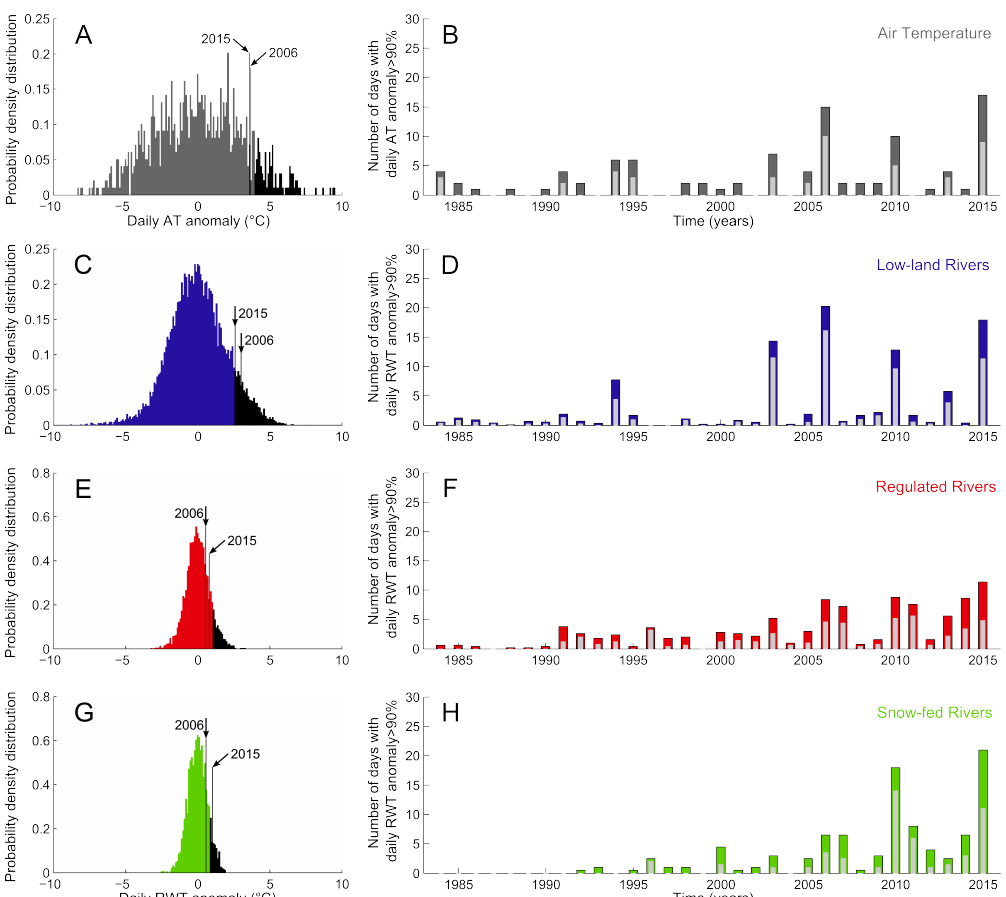
Figure 4. Distributions of daily anomalies during July, considering air temperature ( A ) and water temperature for low-land ( C ), regulated ( E ) and snow-fed ( G ) rivers. Shaded areas show the top 90th percentile in the distribution and arrows indicate the averaged anomalies for the two heatwaves in 2006 and 2015. The number of days exceeding 90% is shown in the right column ( B , D , F , H ) for the period 1984–2015, with inset bars indicating the number of consecutive days. Table 2. Results from correlation analysis (Pearson correlation coefficient R , and significance level p of the F test) between the 32-year time series of AT and RWT warm days (i.e., temperature anomalies warmer than the 90th percentile) and low flow days (i.e., SF anomalies lower than the 10th percentile). Results are listed for the different river categories, analyzed periods (JJA and J), and pairs of variables (AT vs. RWT, AT vs. SF, RWT vs. SF). Correlation is considered statistically significant for p -value < 0.01. AT vs. RWT AT vs. SF RWT vs. SF R p